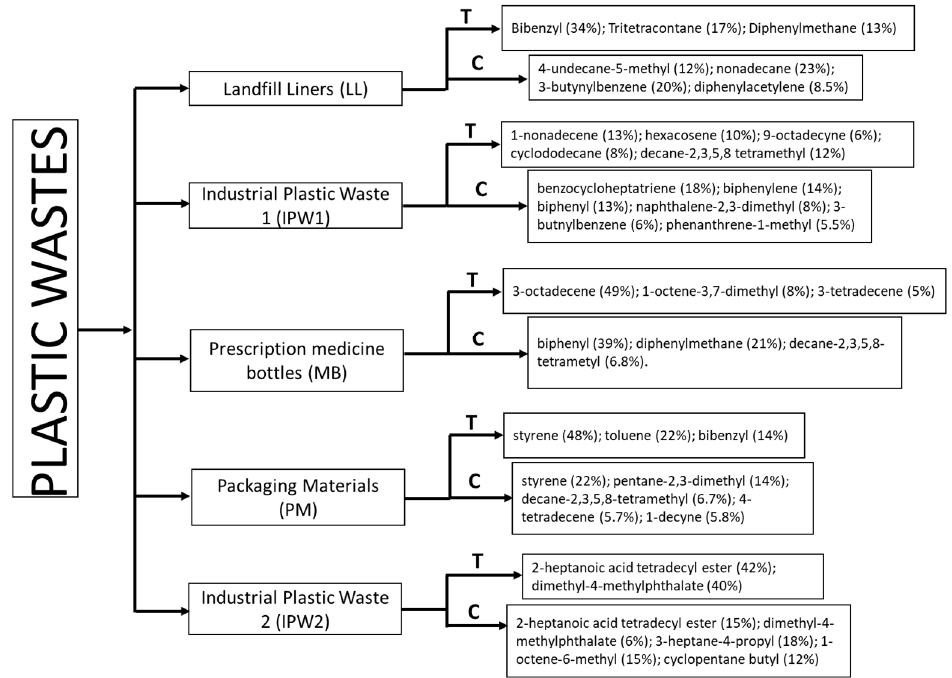
Figure 8. Summary of product distribution from five different plastic wastes using pyrolysis-GC/MS experiments at 600 °C temperature (T = thermal or non-catalytic pyrolysis, C = catalytic pyrolysis); only products with more than 5% chromatographic area are